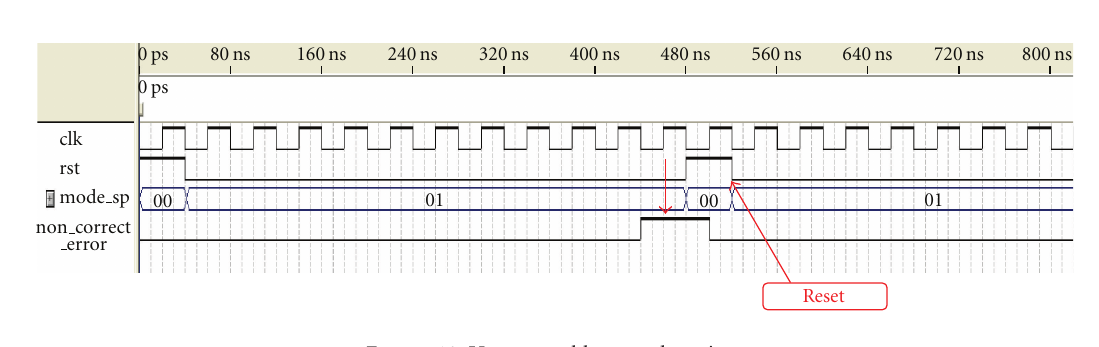
Figure 19: Unrecoverable error detection.